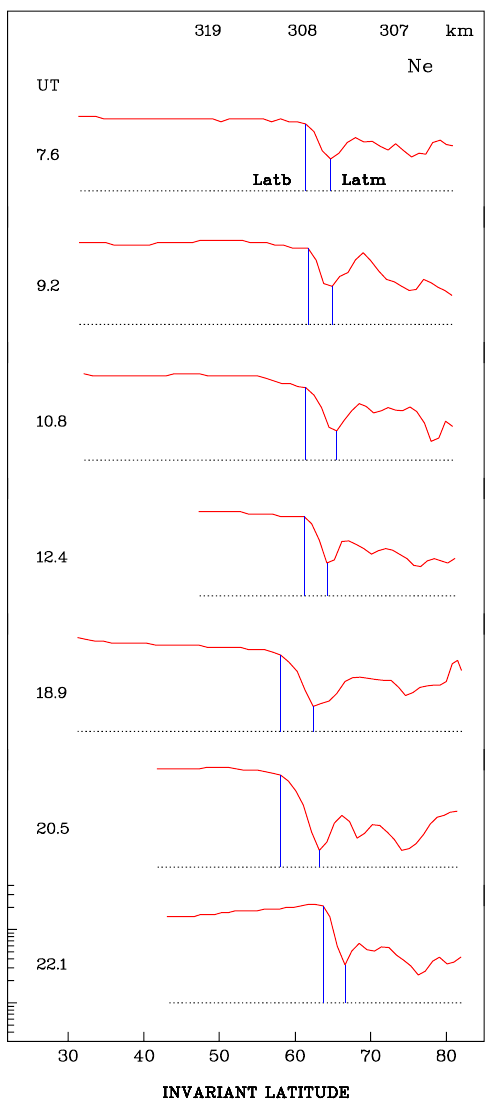
Fig. 1. Examples of relatively simple ionospheric trough structures. A sequence of seven latitudinal profiles of the electron density is shown, as obtained by the DE-2 satellite on 9 December 1981. The universal time of observation is indicated to the left of each profile. The density is plotted on a logarithmic scale, an example of which is shown in the bottom part of the figure. For each profile, a dotted line marks the 10 11 m − 3 density level. The data refer to the northern winter hemisphere, and at 60 ◦ inv. latitude the solar zenith angle is larger than 105 degrees. Solar local time of observation was approx- imately 17:40h, and the magnetic local time varied between about 17:00 and 19:00h. Typical observation heights are indicated at the top of the figure. The geomagnetic activity was relatively weak, with the AE 6 index varying between 155 and 281nT. For each pro- file, vertical blue lines mark the equatorward ( latb ) and poleward ( latm ) boundaries of the density drop in the equatorward trough wall. The associated densities are denoted as Ne(latb) = Neb and Ne(latm) = Nem ,